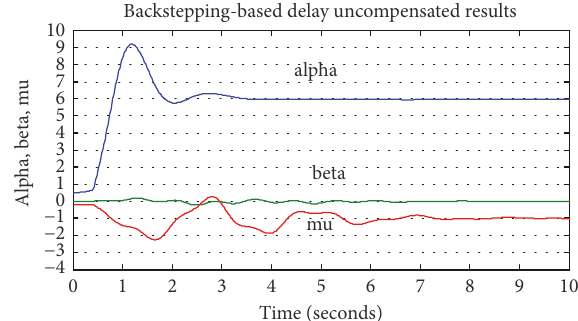
Figure 3: Compensated tracking results.